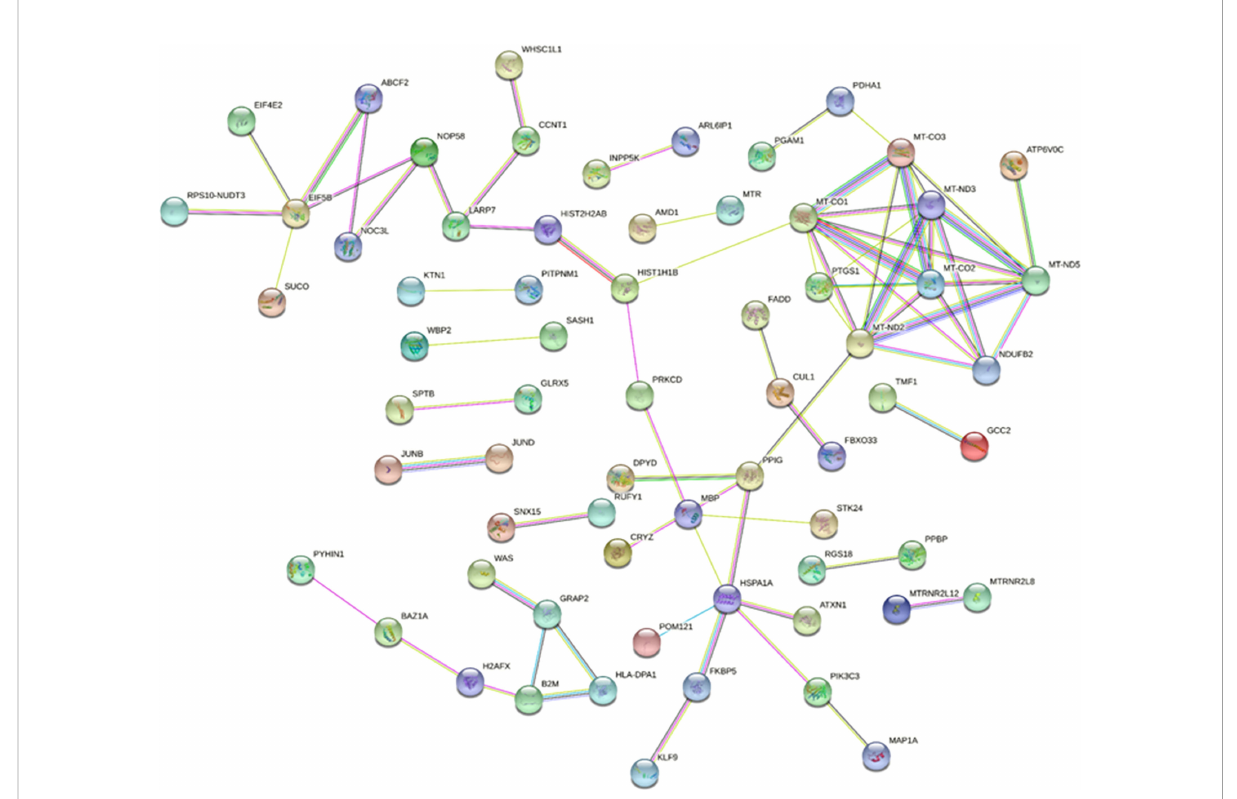
FIGURE 7 The protein − protein interaction network of DEMs. Network nodes represent proteins, and edges represent protein − protein